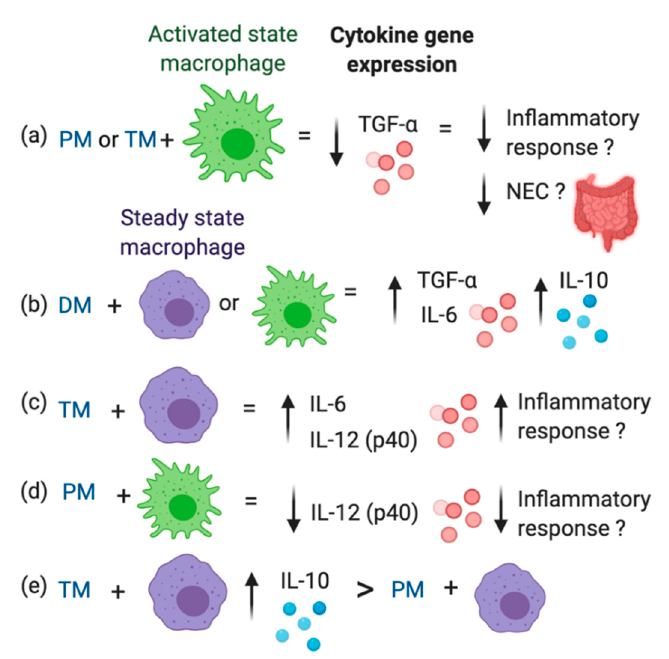
Figure 3. Overview of cytokine gene expression by macrophage-like cells derived from the monocytic cell line THP-1 treated with pooled milk from preterm-delivering mothers (PM), term-delivering mothers (TM), or pasteurized donor milk (DM). ( a ) In the activated state, TNF- α gene expression in macrophages treated with PM or TM was lower than in macrophages not treated with milk (control) or macrophages treated with DM. ( b ) IL-10 gene expression in macrophage-like cells treated with DM was higher compared with raw PM (steady state cells) and TM (activated cells). ( c ) TM increased IL-6 and IL-12 (p40) gene expression by steady state macrophages compared to the control, but PM did not. ( d ) In activated macrophages, PM reduced expression of IL-12 (p40), whereas TM did not. ( e ) IL-10 gene expression in steady state macrophage-like cells treated TM was higher compared with PM.